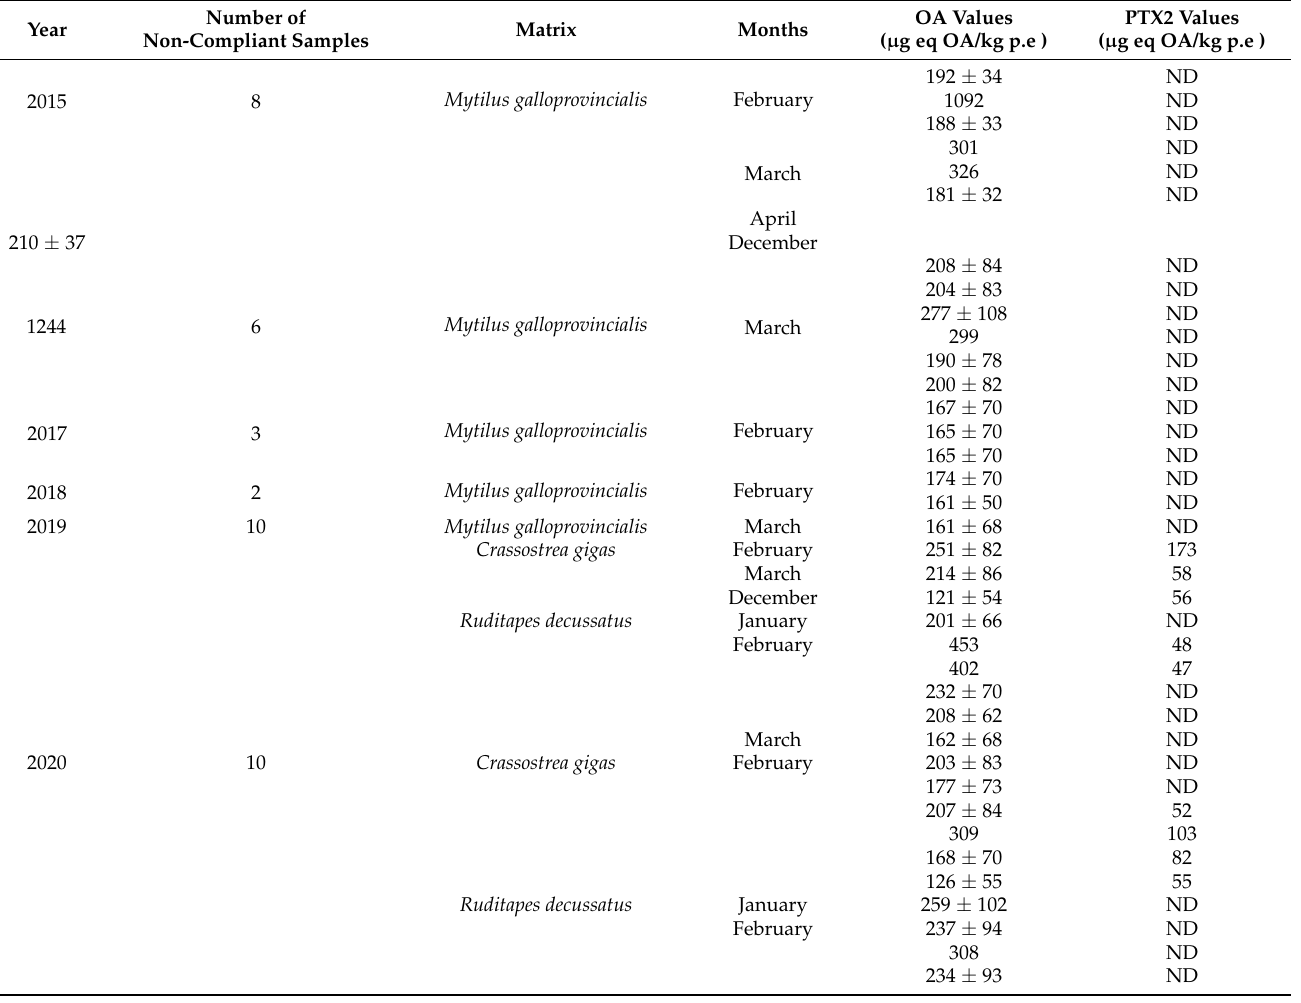
Table 4. Distribution of non-compliance referring to OA and PTX2 between the years 2015 and 2020.